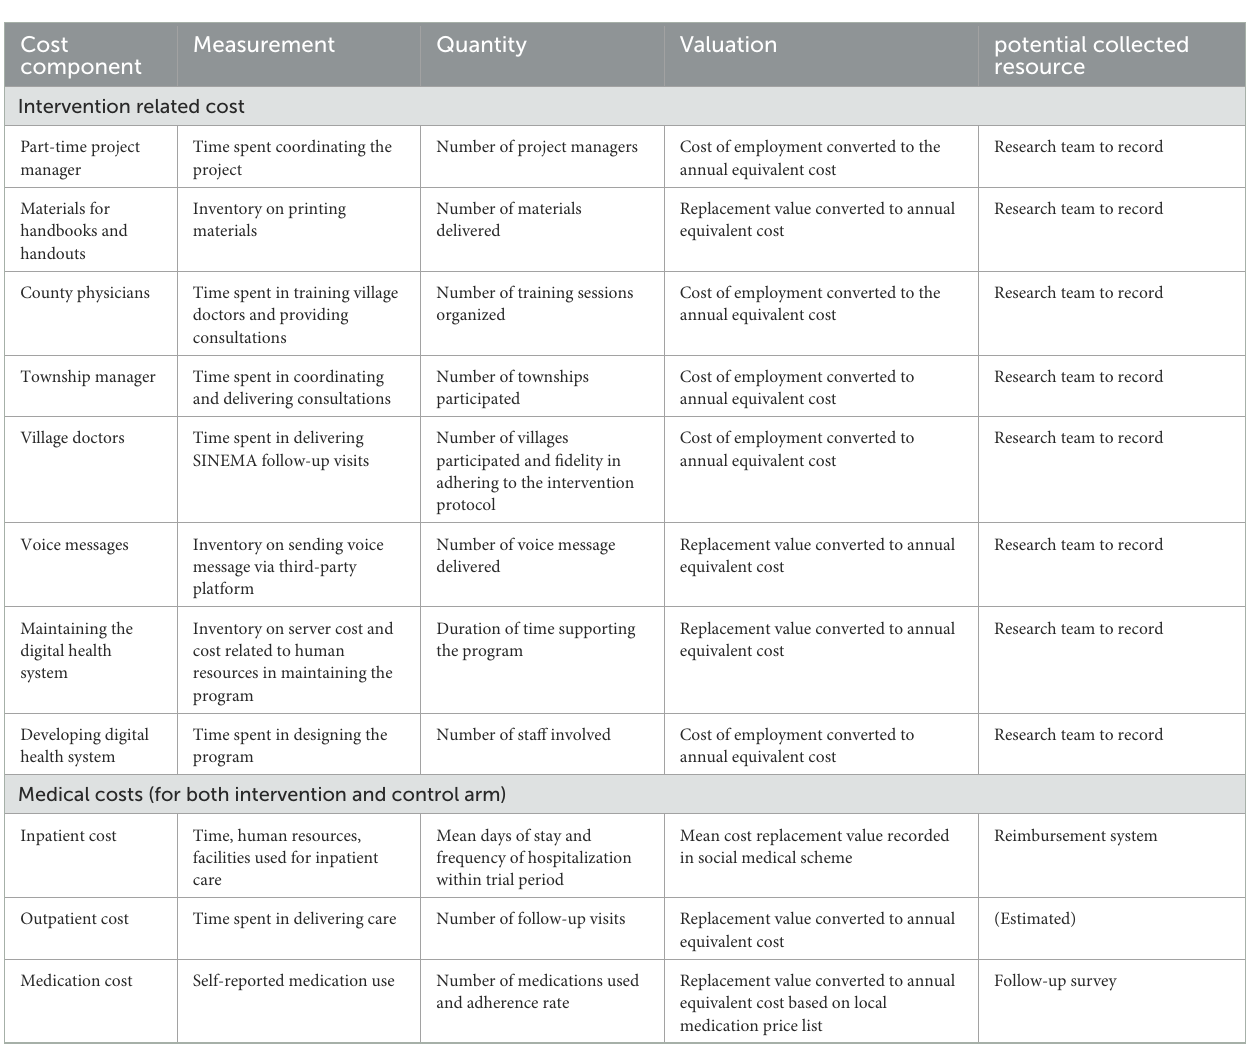
TABLE 1 Resource use information collected and measured for